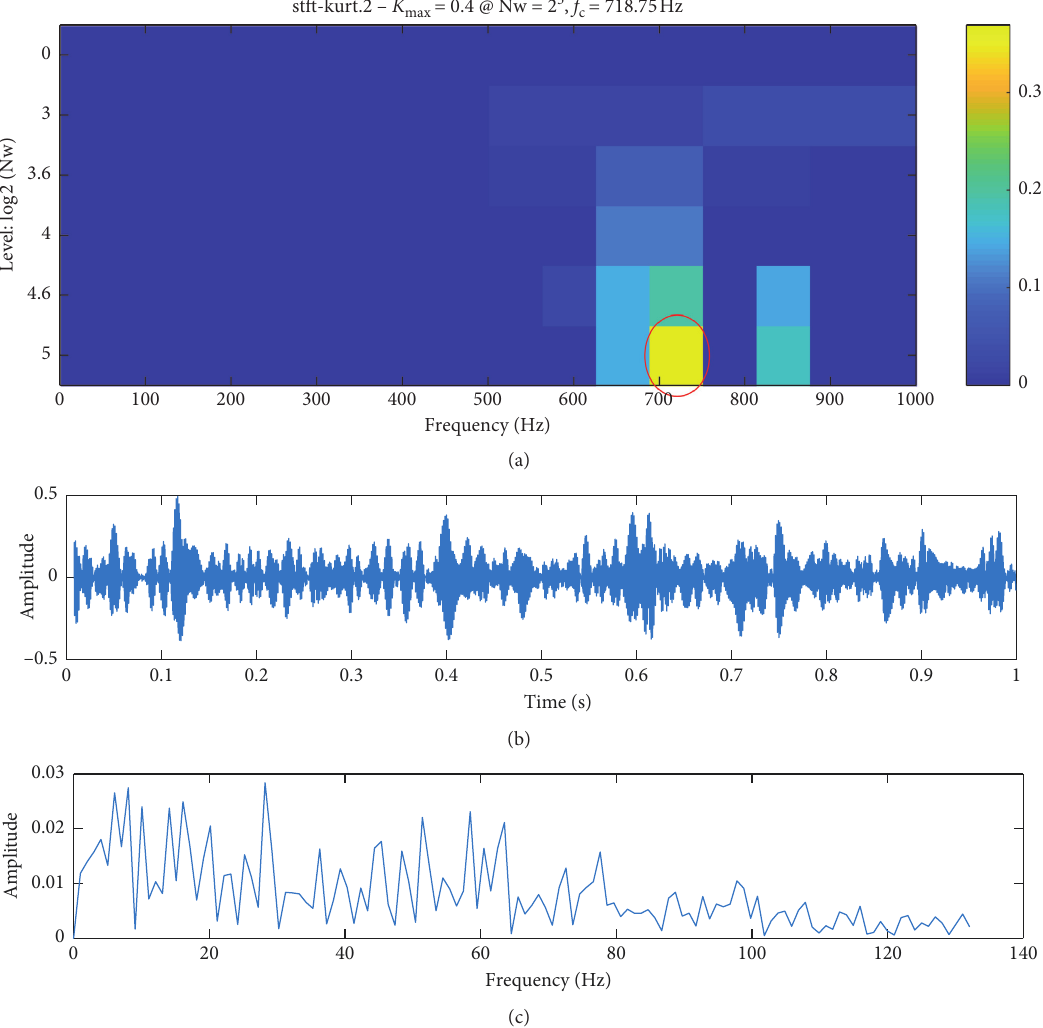
Figure 11: Simulated signal in Figure 6(b) processed by the SK: (a) the paving of kurtosis values and (b) the signal filtered by frequency band (expressed by a solid read circle); (c) envelope spectrum of the filtered signal.